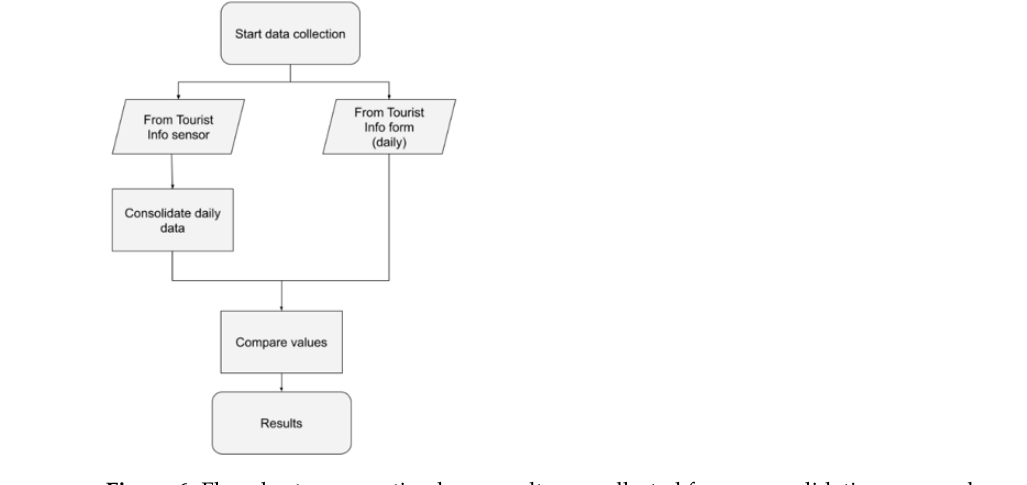
Figure 6. Flowchart representing how results are collected from our validation approach. Table 1. Crowd monitoring results by using HOPU Smart Spots vs. data collected by surveys.